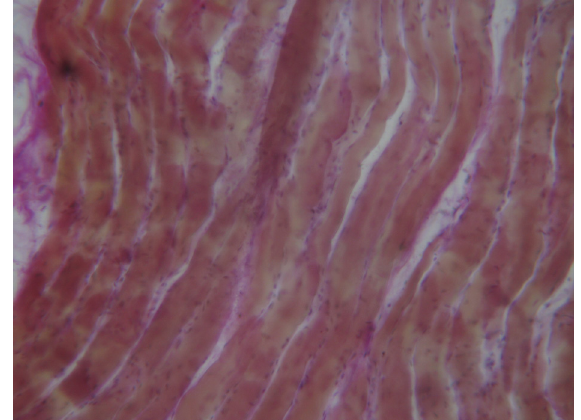
Figure 1. Microstructure of an ear tissue sample before processing with the ferment preparation Protepsin, magn. 400.